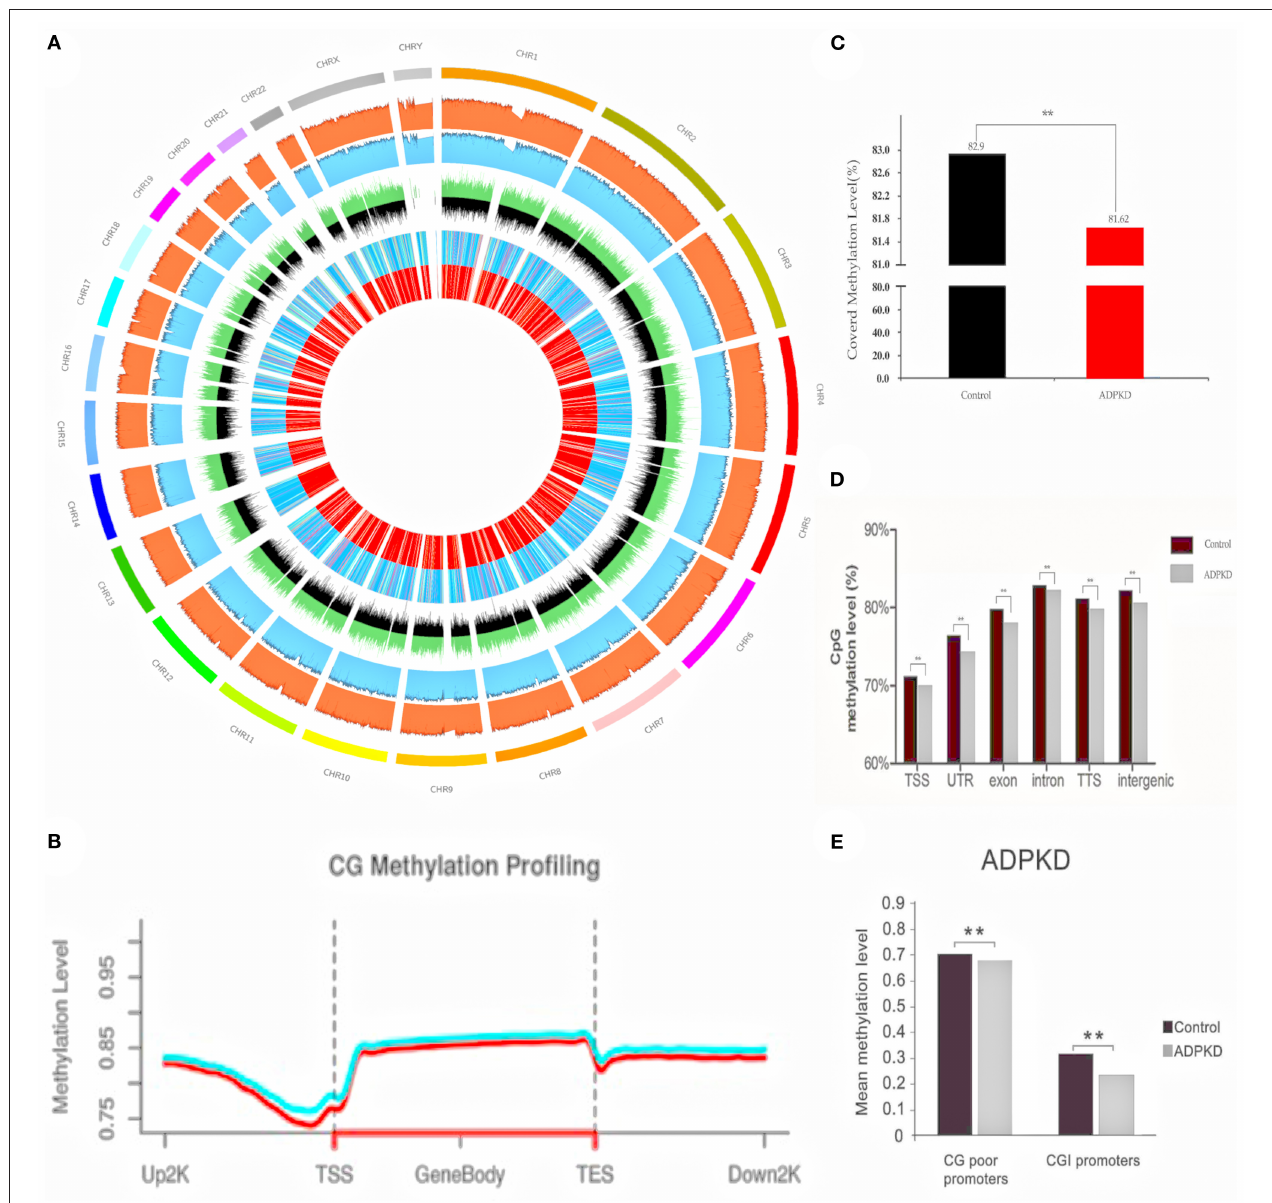
FIGURE 2 | WGBS of five non-ADPKD and five ADPKD kidneys. (A) Circos representation of genome-wide DNA methylation levels in the non-ADPKD and ADPKD groups. Average levels for all of the CGs in 29710-Mbp windows. The inner track indicates the magnitude of the difference between the non-ADPKD and ADPKD groups for each window (color scale and red line). Average methylation levels in all of the regions are expressed as β -values (0–1) and are colored blue. (B) CG methylation profiling graph for the non-ADPKD group (green line) and the ADPKD group (red line). (C) Methylation level of covered CpG in the non-ADPKD group and the ADPKD group (rank-sum test, ** p < 0.01). (D) Mean CpG methylation levels among different genomic sequences in the non-ADPKD group and the ADPKD group (rank-sum test, ** p < 0.01). (E) Mean CpG methylation levels among promoters in the non-ADPKD and ADPKD groups in the presence or absence of a CpG